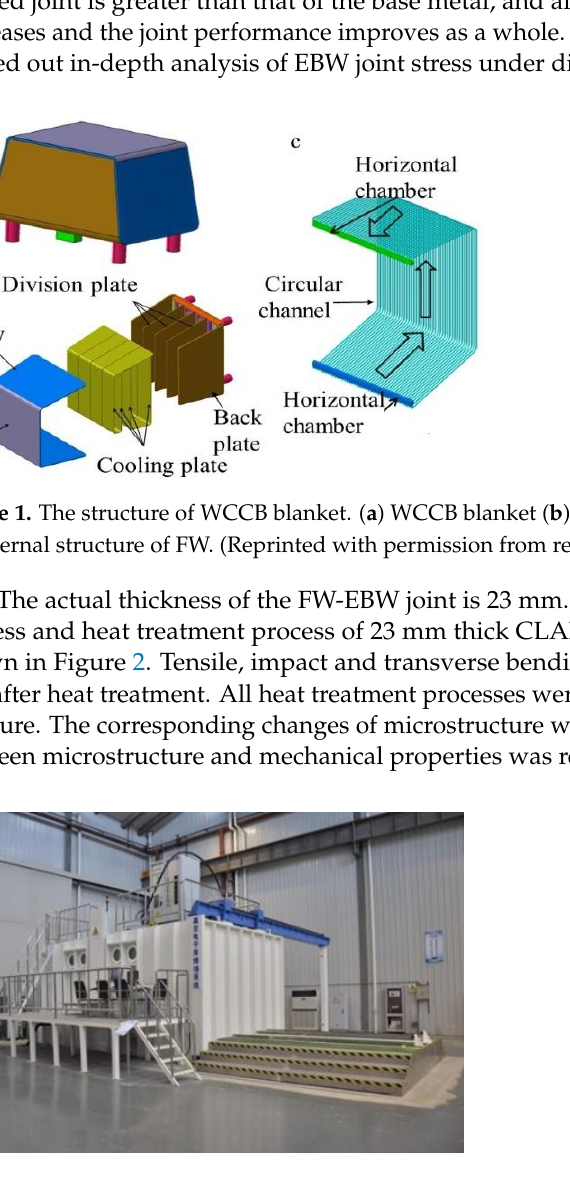
Figure 2. The equipment of EBW. (Reprinted with permission from ref. [13] © (2019) Elsevier).